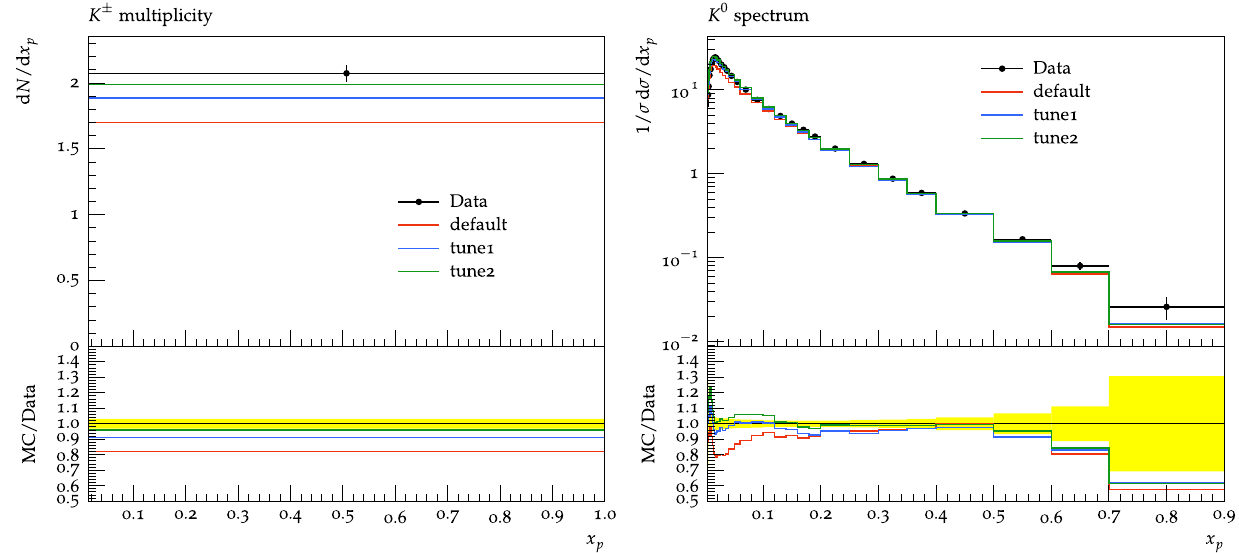
√ s = 91 . 2GeV. We show a comparison